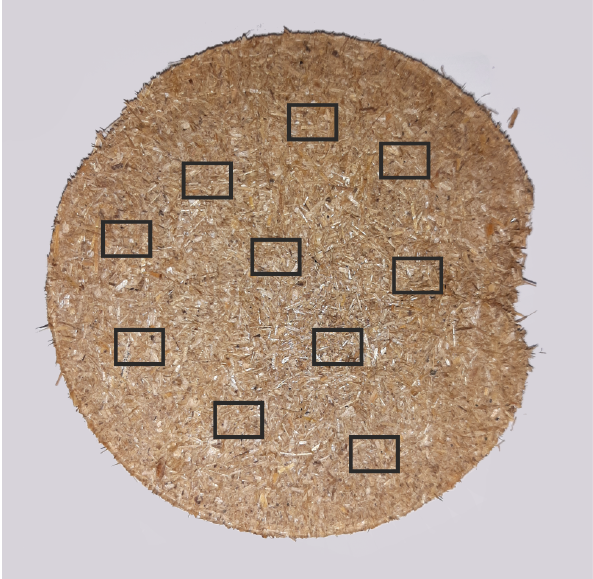
Figure 2. Sample material of 100% wheat straw (biofuel type 5).